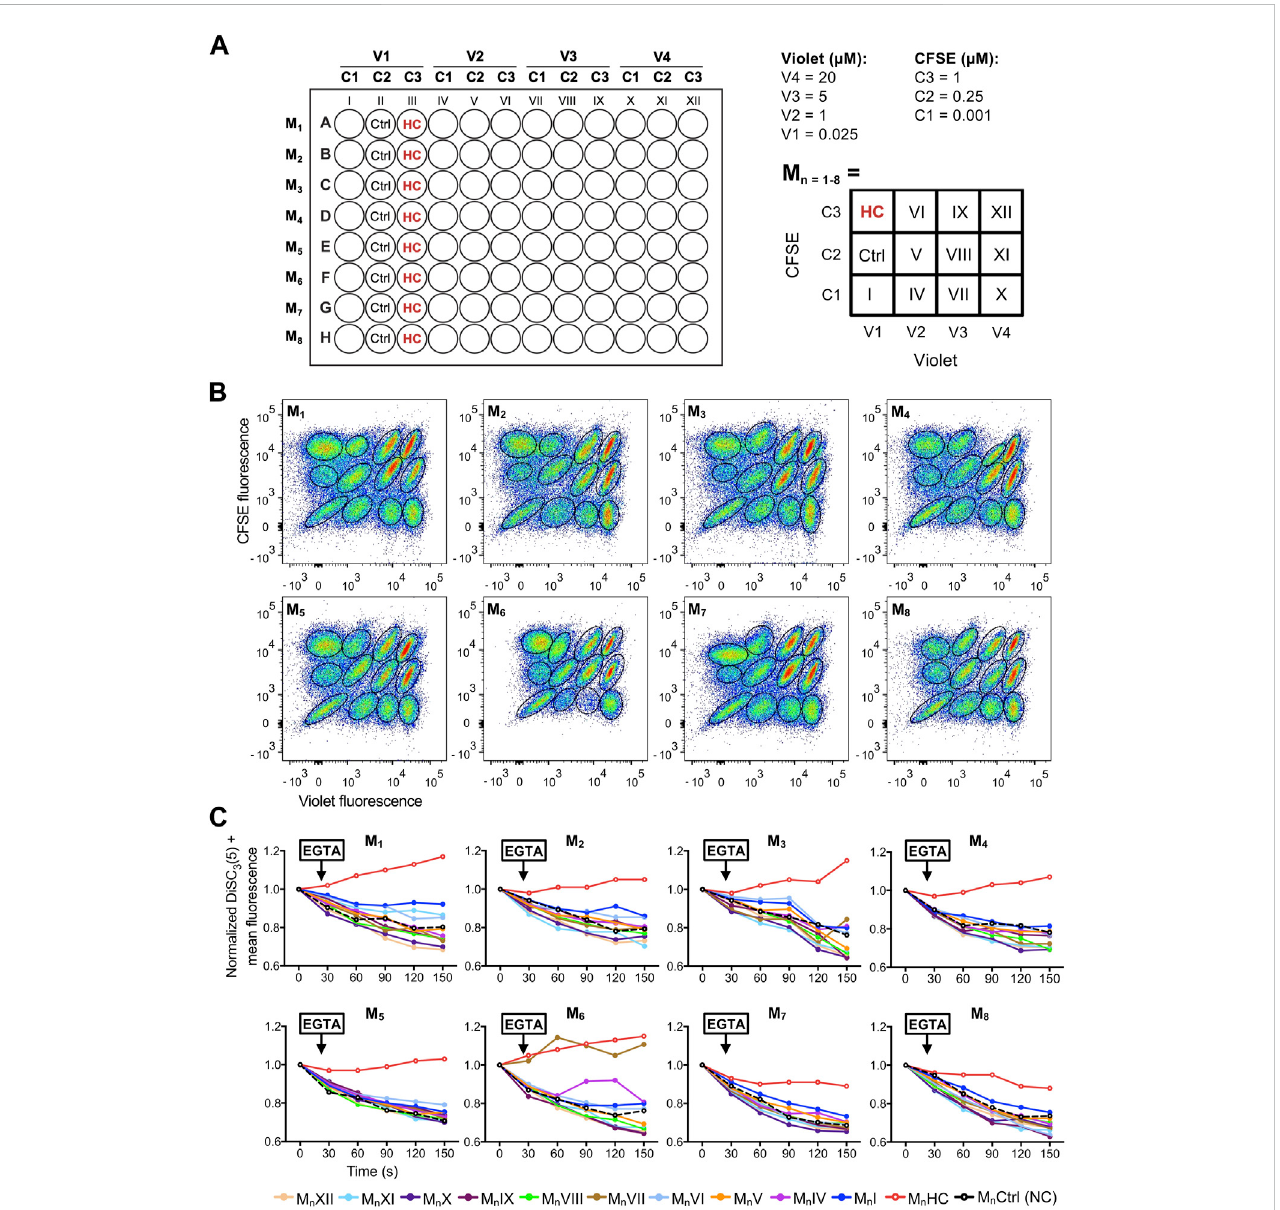
different matrix (M n=1 – 8 ). Right-panel: schematic diagram of the compound arrangement within each 4 × 3 matrix. The dye concentration in each location is depictedasadouble-entrytable. (B) Representative2DdotplotsofCellTrace ™ Violetvs.CellTrace ™ CFSE fl uorescenceoftheeight4×3matrixesfrom the 96-well plate, where the population of sperm with each dye combination/signature was de fi ned. (C) DiSC 3 (5) fl uorescence mean was determined in DiSC 3 (5) + population before (time = 0 s) and after (black arrow) addition of 3.5 mM EGTA. In each condition, the fl uorescence mean was normalized to the basal fl uorescence (0 s). Each color represents a different compound (M n I-XII; n = 1 – 8) obtained through its corresponding dye fl uorescence